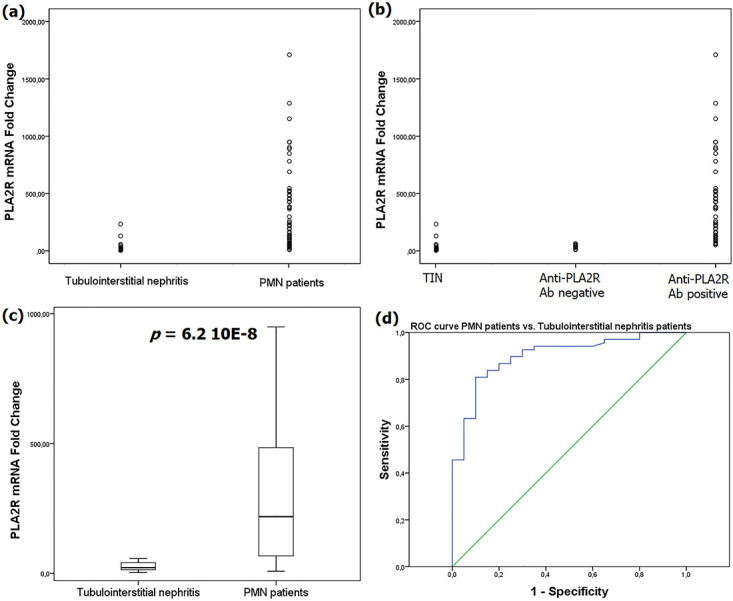
PLA2R mRNA relative expression in PMN and TIN.For each sample a relative expression of PLA2R to podocin was calculated. Then a fold-change for relative PLA2R expression was obtained from the calibrator. (a) Dot plot highlighting higher levels of renal PLA2R in PMN patients. (b) Dot plot showing PLA2R mRNA levels in TIN patients and PMN patients positive and negative for anti-PLA2R Ab. (c) Box plot emphasizing significant higher PLA2R mRNA levels in PMN patients. (d) ROC curve for PLA2R mRNA levels in PMN diagnosing: ROC curve: 90% [0.827–0.972], p<0.0001; cut-off = 57.68, specificity = 90%, sensitivity = 80.9%.